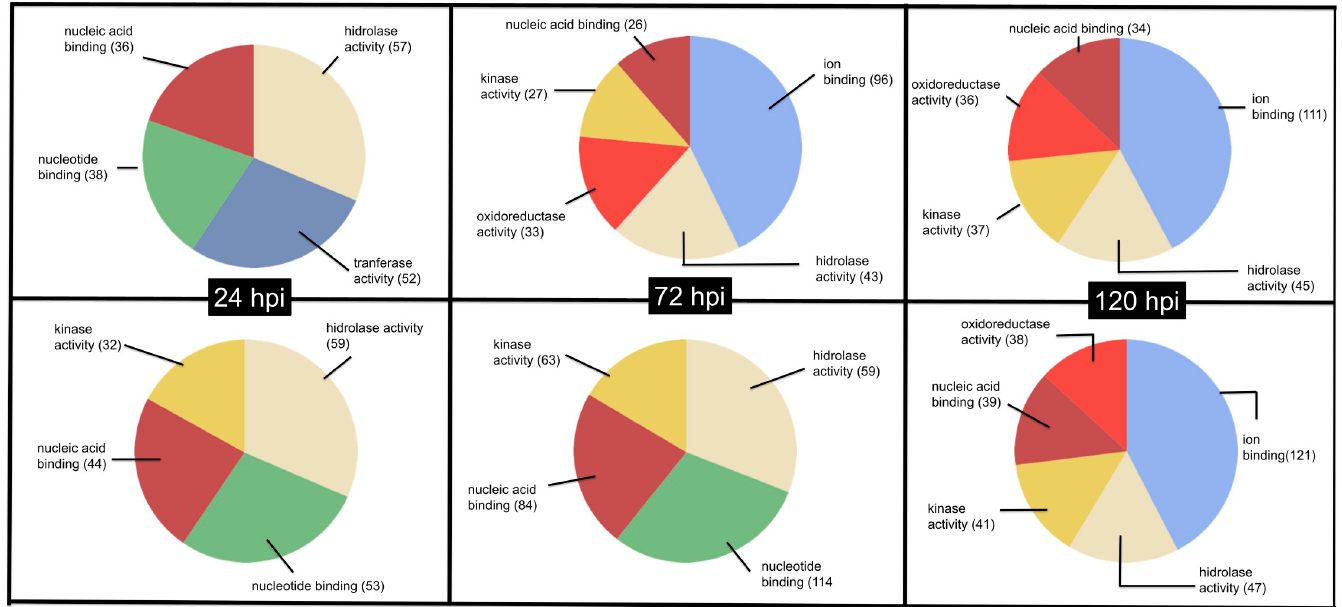
Fig 3. GO distribution for molecular function of DEG in oil palm clones during interaction process with P . palmivora . Top panel Ortet 34 (Resistant), Bottom panel Ortet 57 susceptible.